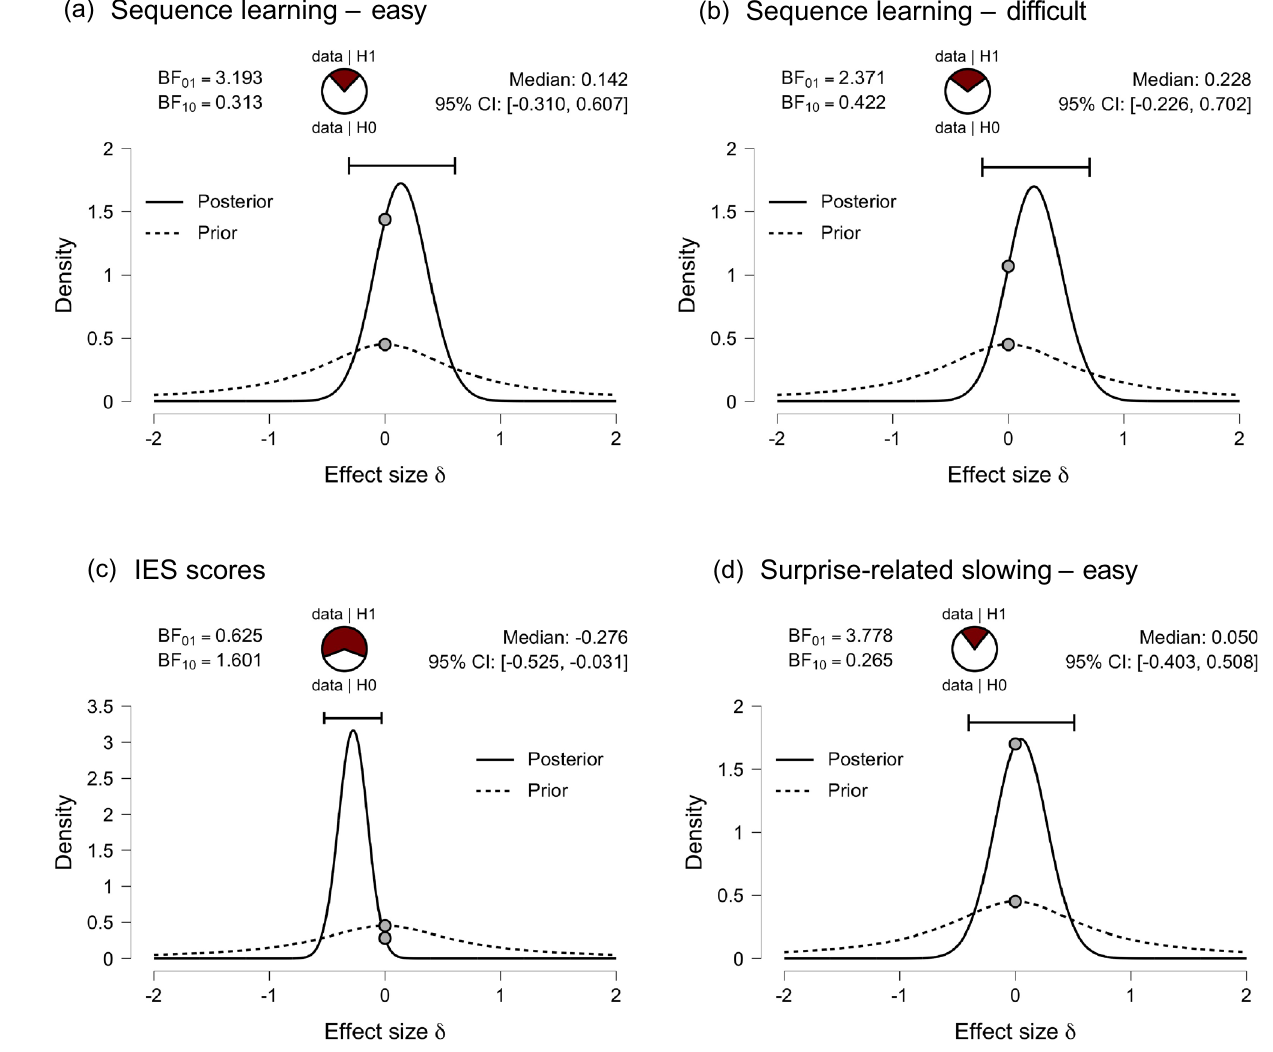
Figure 3. Bayesian statistical testing. The Bayes factor (BF 01 ) indicates the evidence for the null hypothesis of no difference between groups. The density distribution displays the prior and posterior distribution for the population effect size, with the median effect size estimated, and a 95% credible interval which contains the median effect size. ( a ) Sequence learning – easy : BF 01 = 3.193, meaning that the data are over three times more likely under H0 and provide moderate support for null hypothesis of no difference between groups ( b ) Sequence learning – difficult: BF 01 = 2.371, meaning that the data are over two times more likely under H0 and provide anecdotal support for the null hypothesis of no difference between groups. ( c ) Bayesian paired t-test for IES scores in the predictable difficult condition compared with the unpredictable condition. BF 01 = 0.625, meaning that the data are more likely under H1, providing weak support for the alternative hypothesis of a difference between conditions. ( d ) Surprise-related slowing – easy condition . BF 01 = 3.778, meaning that the data are over three times more likely under H0 and provide moderate support for null hypothesis of no difference between